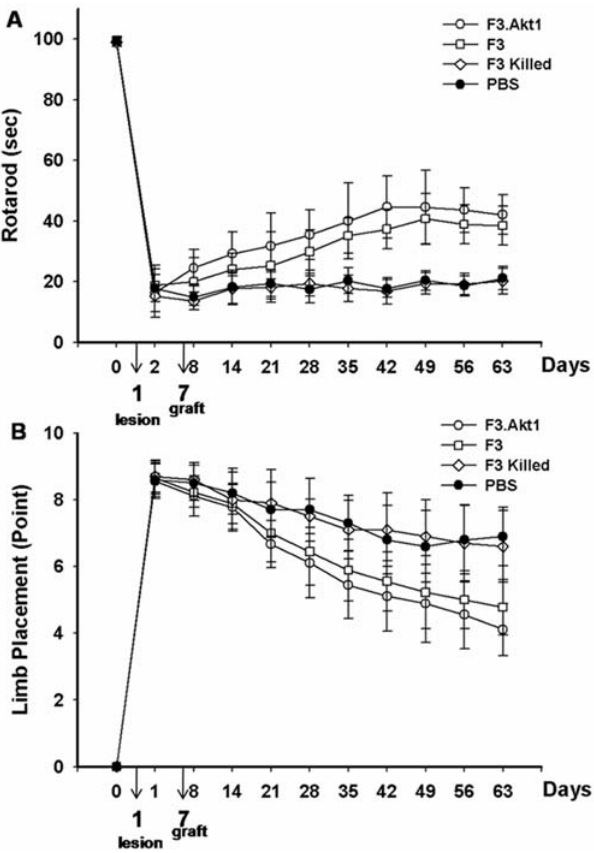
Figure 3. Behavioral improvement demonstrated in intracere- bral hemorrhage (ICH) mice transplanted with F3 or F3.Akt1 human NSCs. A: Rotarod test. F3.Akt1-transplanted group showed better performance than PBS controls or F3 cell group, killed F3.Akt1 cell group 8 days onward, and these benefits continued up to 8 weeks post-transplantation (* P , 0.05). B: In the modified limb placement test, F3.Akt1-transplanted group showed better performance than PBS, F3 or killed F3.Akt1 group (* P ,